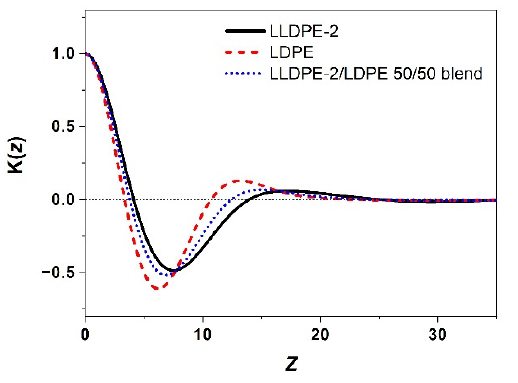
Figure 9. The linear and the Lorentz-corrected profiles of the neat LLDPE-2, the neat LDPE, and the LLDPE-2/LDPE blend.